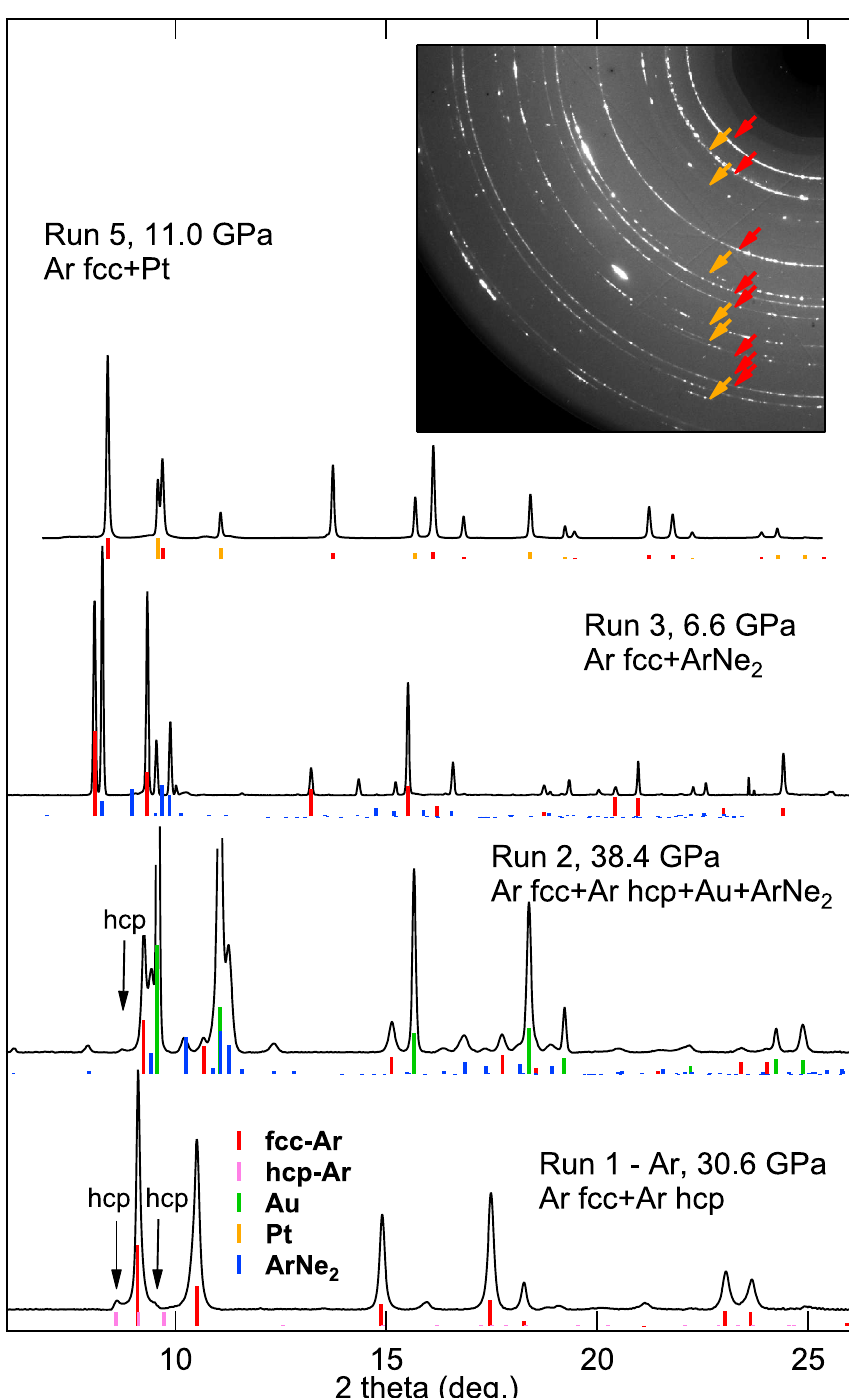
Figure 4. XRD patterns collected for four experimental runs at various pressures. Tick marks indicate the positions and predicted intensities for perfect powders of each compound in the pressure chamber; the arrows indicate the positions of diffraction peaks for hcp-argon. The inset represents the XRD image corresponding to run 5 pattern. In this run, argon sample was a fine powder and XRD rings are identified with red and orange arrows, corresponding to fcc Ar and platinum,